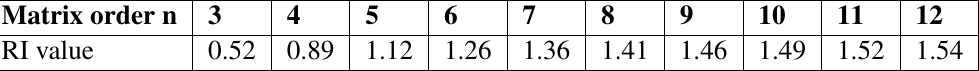
Table 7 RI value changes with the matrix order n.